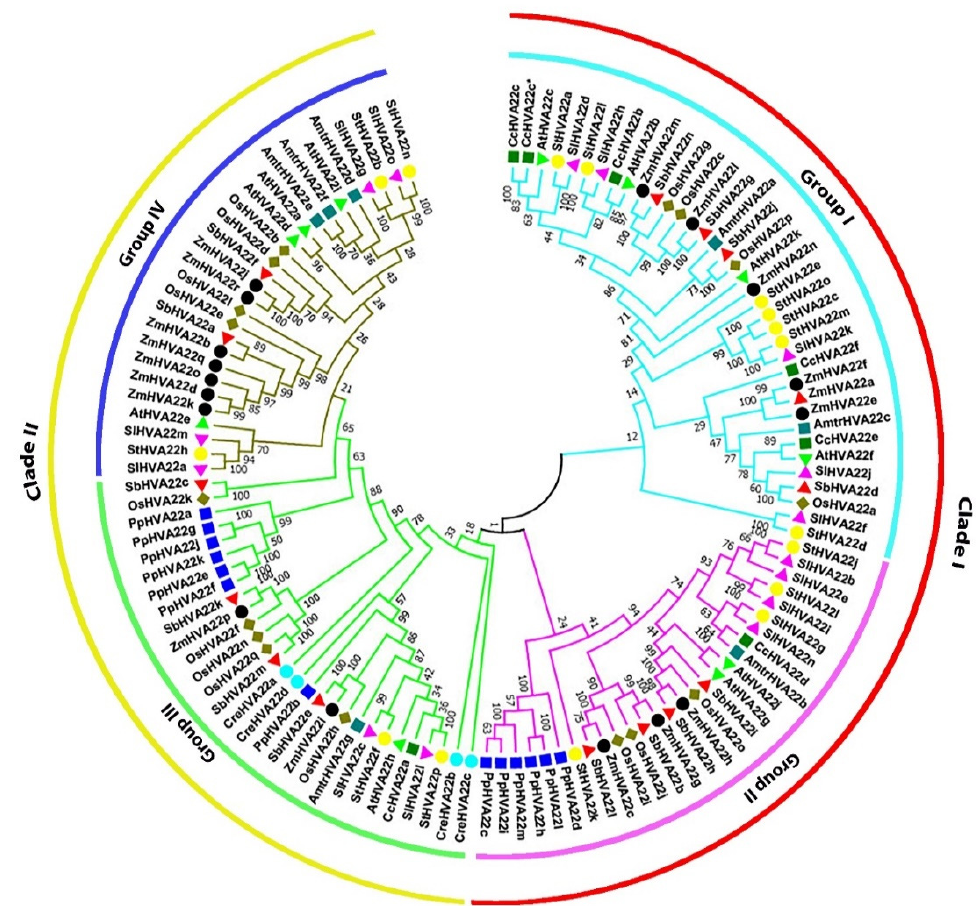
Figure 1. Phylogenetic analysis of HVA22 proteins from tomato and different plant species. The neighbor-joining tree was constructed with the full length HVA22 proteins using ClustalW and MEGA11 with 1000 bootstrap replicates. A species abbreviation was provided prior to each